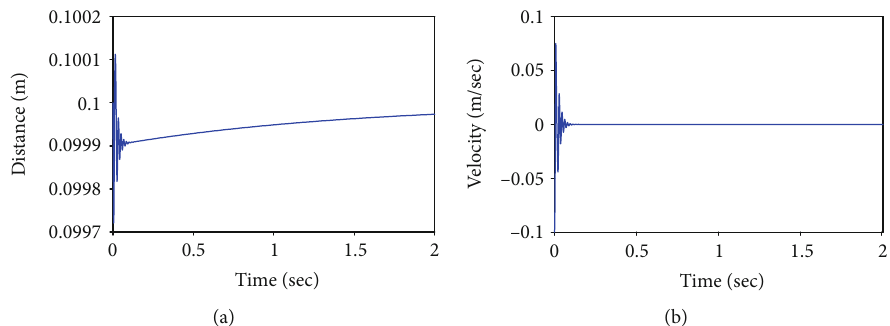
Figure 8: Dynamic response of two contact objects ( stiffness = 0 , damping = 1000 ): (a) relative distance of S and S 2